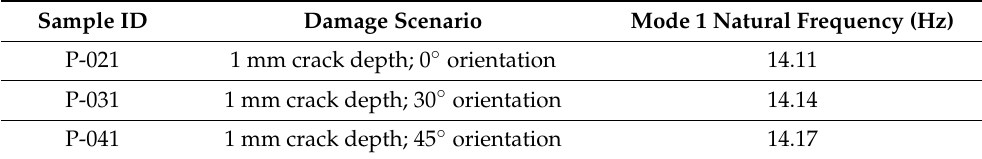
Table 2. First mode natural frequency of MSE-DI hybrid-stiffened